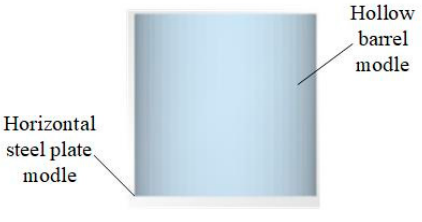
Figure 2. Equipment model.